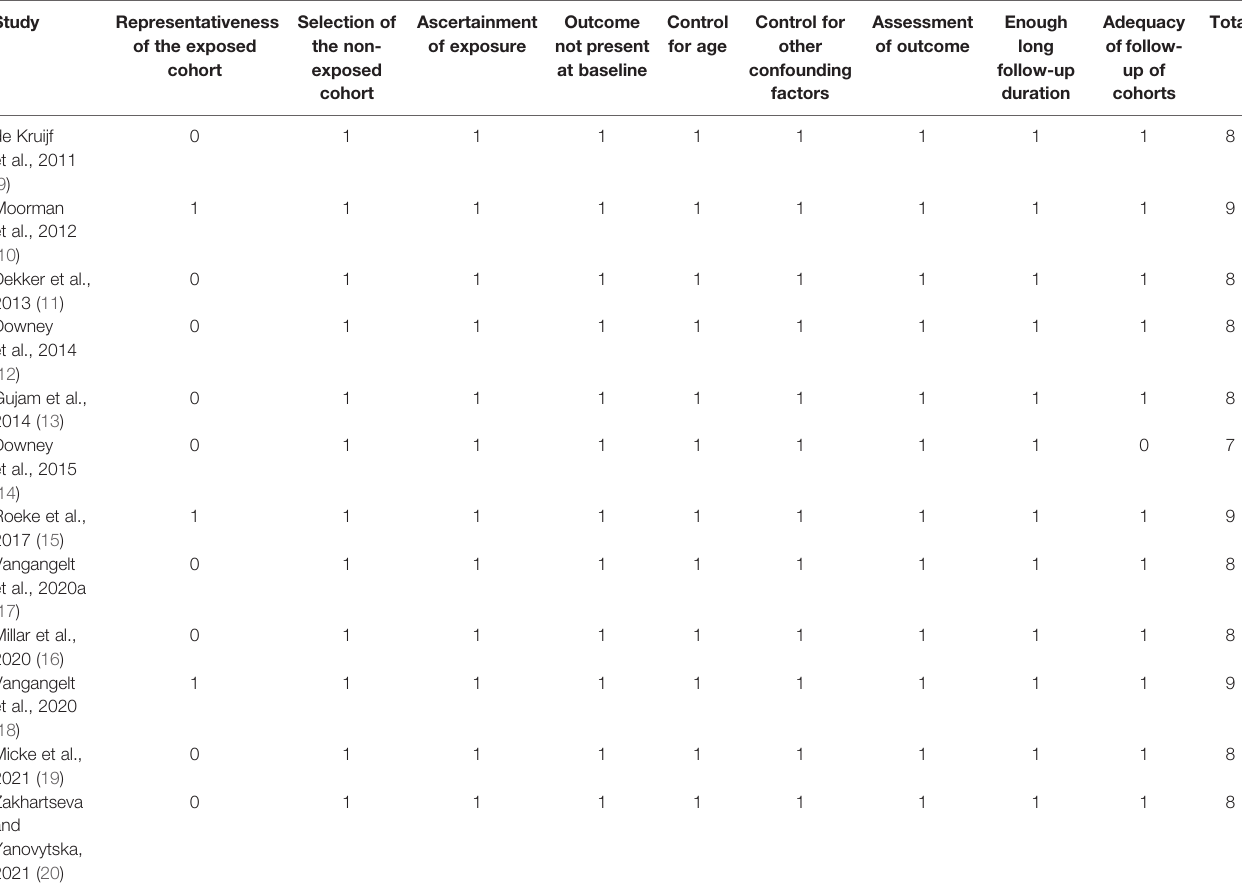
TABLE 2 | Details of study quality evaluation via the Newcastle-Ottawa